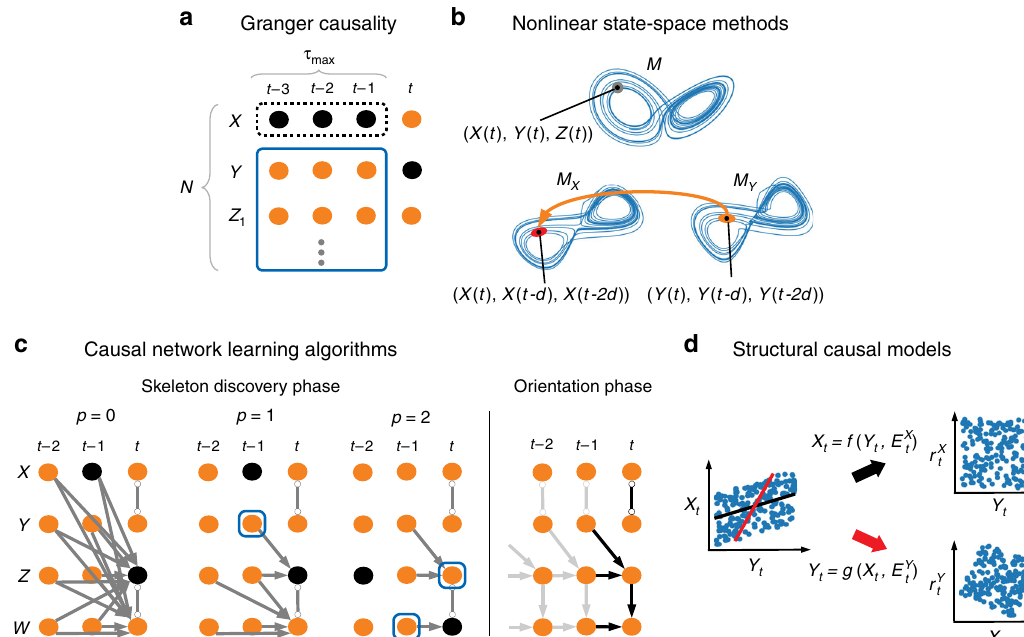
Fig. 2 Overview of causal inference methods. a Multivariate Granger causality tests whether omitting the past of a time series X (black dashed box) in a time series model including Y ’ s own and other covariates ’ past (blue solid box) increases the prediction error of Y at time t (black node). Hence, only time- lagged causal relations can be found. b The nonlinear state-space method convergent cross-mapping (CCM), illustrated for the chaotic Lorenz system, reconstructs the variables ’ state spaces (M X , M Y ) using time-lagged coordinate embedding and concludes on X → Y if points on M X can be predicted using nearest neighbors in M Y (orange ellipse) and the prediction improves the more points on the attractor are sampled. c Causal network learning algorithms cope well with high dimensionality and can often also identify the direction of contemporaneous links. Exempli fi ed on the model of Box 1, the PC algorithm 12 , adapted to time series, starts from a graph where all unconditionally ( p = 0) dependent variable pairs (assuming stationarity, only links ending at time t are represented) are connected and iteratively tests conditional independence with increasing number of conditions p . Lagged links are oriented forward in time (causes precede effects), while contemporaneous links are left undirected (circle marks at the ends) in this skeleton discovery phase. For example, X t − 1 and Z t (black nodes) are correctly identi fi ed as independent already in the second iteration step ( p = 1) where the dependence through Y t-1 (blue box) is conditioned out, while we need to condition on two variables to detect that Z t − 2 and W t are independent ( p = 2). In contrast to GC, PC